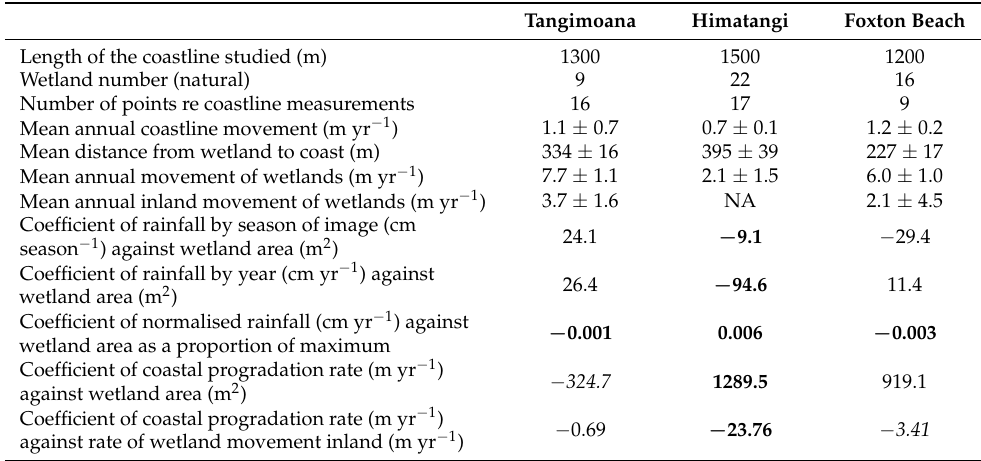
Table 1. Characteristics of the Fox-Tangi coast and its wetlands. The coefficient is the slope of the rate of change of wetland area or of inland movement with rainfall or with coastal progradation rates. Coefficients are bold if correlations (r 2 ) are >0.5 (including many values of 1, i.e., a line fitted to only 2 points, for Himatangi and 1–2 for the other sites), and in italics if <0.4, with normal font for values in between. NA = not appropriate, due to few images covering Himatangi. Tangimoana Himatangi Foxton